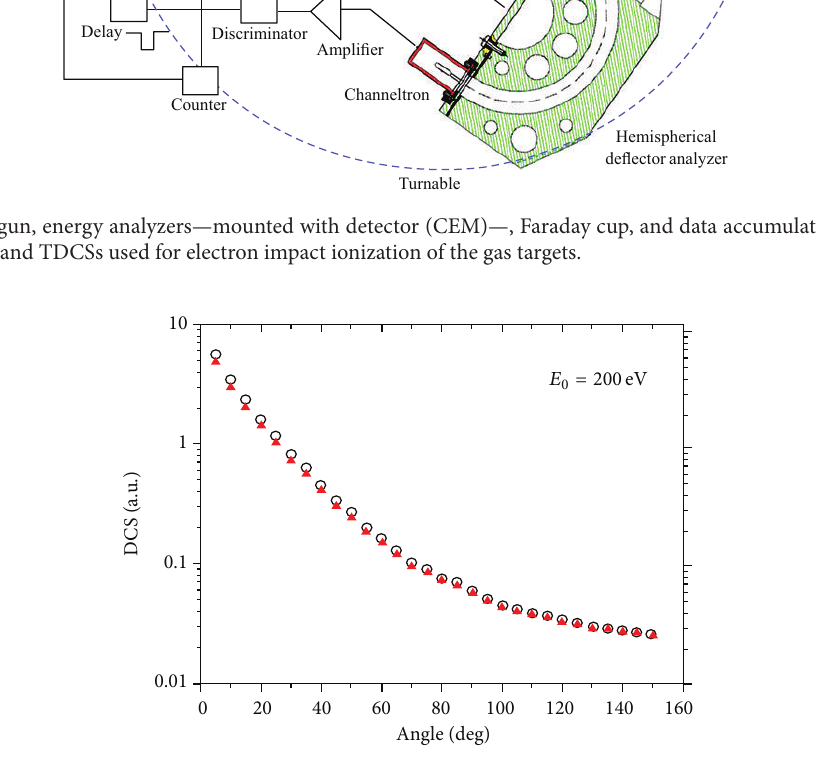
Figure 10: Elastic DCS at 200 eV electron impact energy for He (present data ( I ), Kurepa and Vuskovic ( )